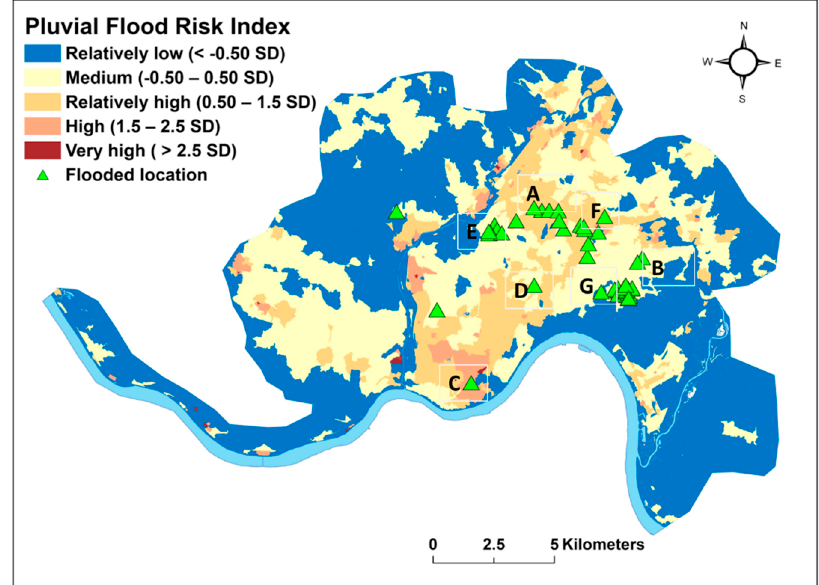
Figure 9. The results of pluvial flood risk index (PFRI). Table 4. Summary of PFRI values for the flooded locations based on PFRI level.